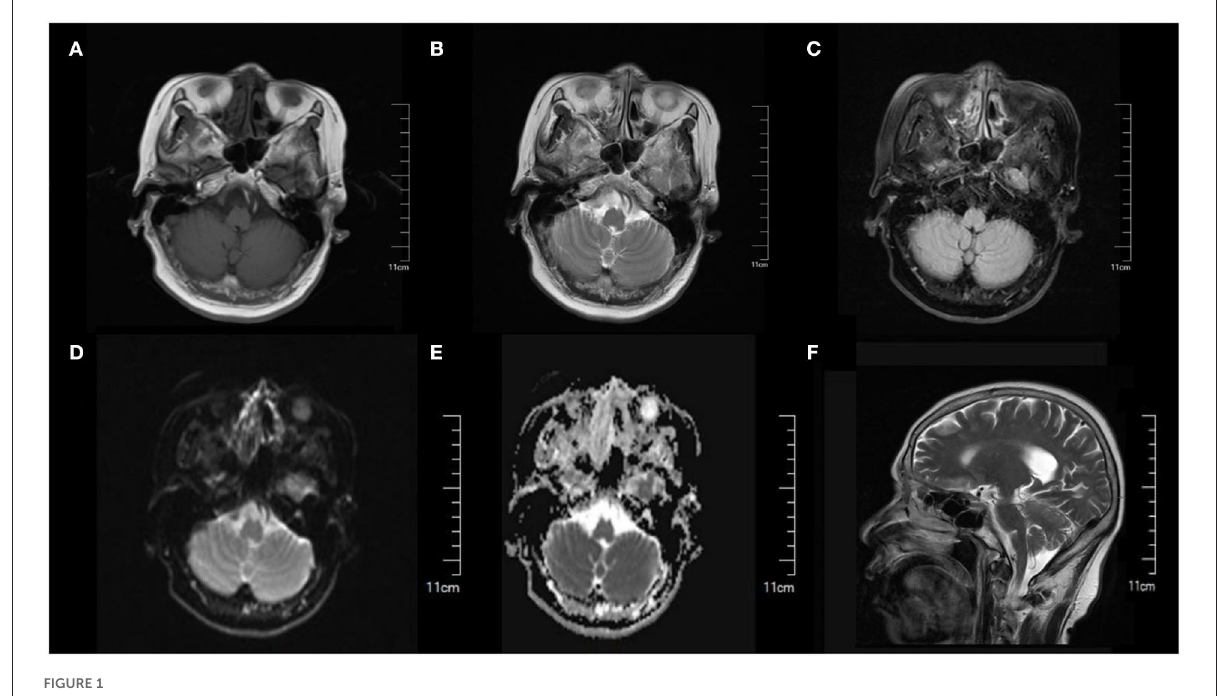
FIGURE1 Cranial MRI showed normal brain structure and no obvious abnormal signal was found. (A) T1-weighted image. (B) T2-weighted image. (C) FLAIR image. (D) DWI image. (E) ADC image. (F) Sagittal section image.